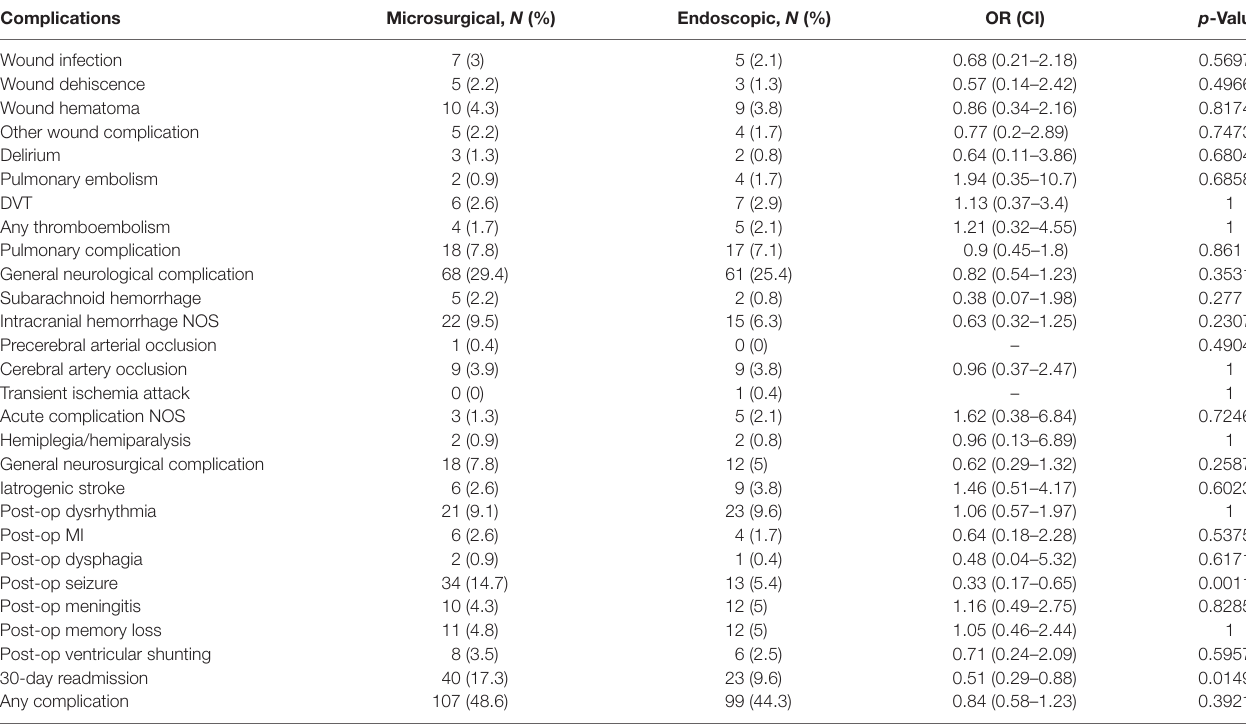
Table 4 | Patient